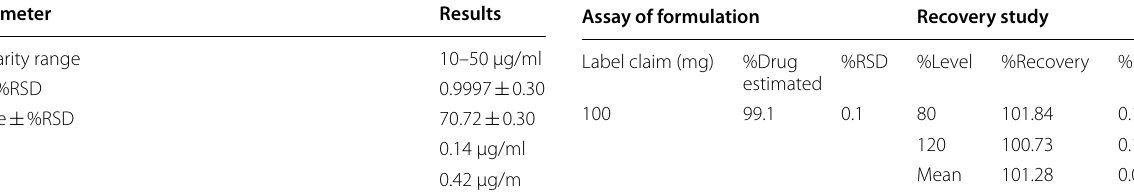
6) Table 12 Formulation assay and recovery study results ( n =